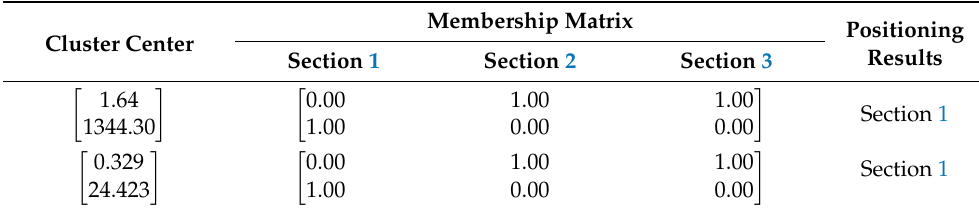
Figure 8. Zero-sequence current waveform of each monitoring point of faulty line. ( a ) First fault data. ( b ) Second fault data. Table 8. The location results of field data